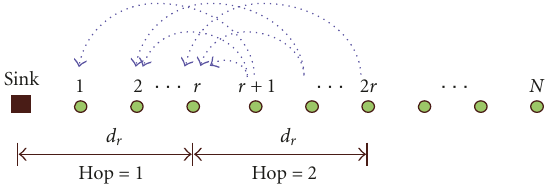
Figure 8: The random parent selection scheme with